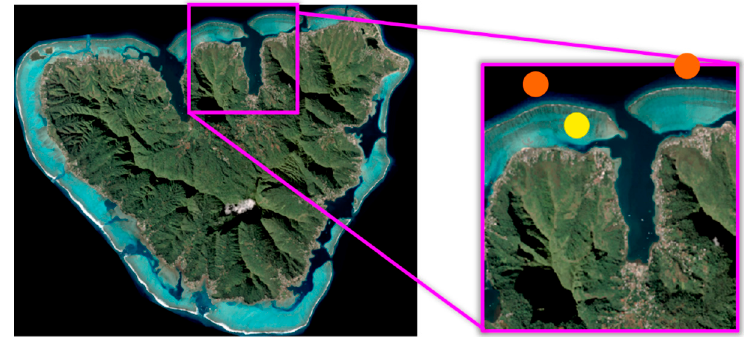
Figure 2. Pleiades satellite image of Moorea, French Polynesia, with the fore (orange circles) and fringing reef (yellow circles) sites investigated within the underwater photogrammetry monitoring project.